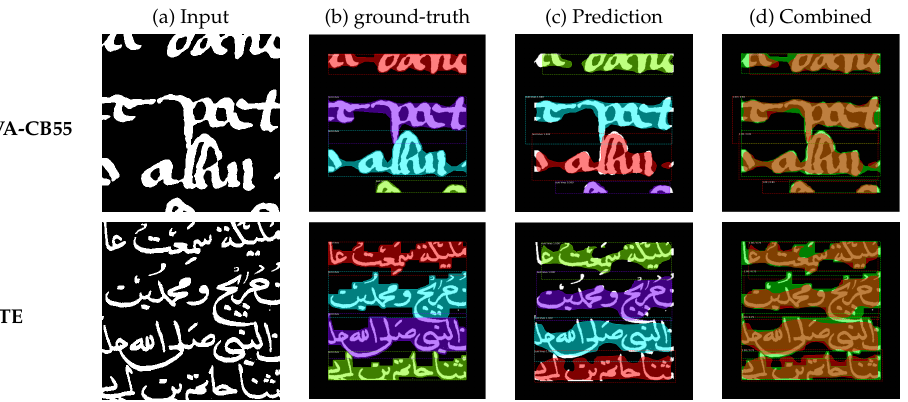
Figure 12. An example of patch prediction using Mask R-CNN: ( a ) an example patches from DIVA- CB55 and VML-AHTE datasets, ( b ) the ground-truth annotation of the patches, ( c ) the prediction results of the Mask R-CNN, and ( d ) the difference between the prediction results (red) and the ground-truth